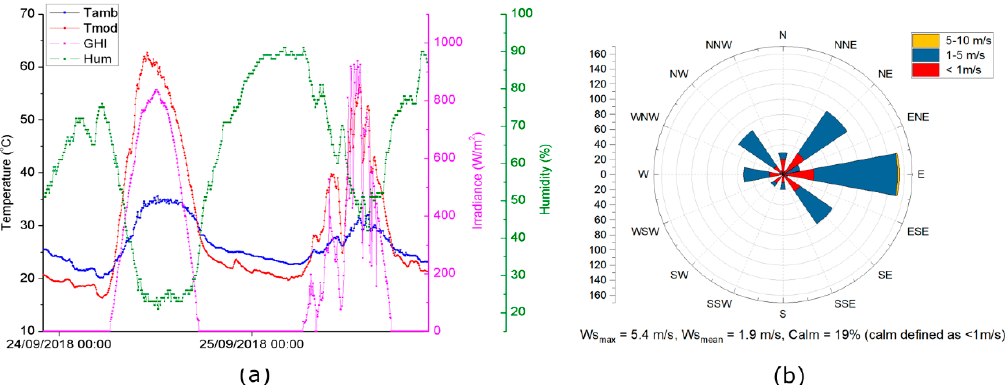
Figure 5. Ambient and thermal parameters during summer time, covering two characteristic days: Clear and cloudy (from 23/09/2108 22:00 to 25/09/2018 22:00, GMT 0, n = 617). ( a ) Thermal evolution of the module (Tmod) located at horizontal face compared to ambient temperature (Tamb), global horizontal irradiance (GHI) and relative humidity (Hum). ( b ) Wind speed distribution with details about the maximum (Wsmax) and average (Wsmean) wind speed.